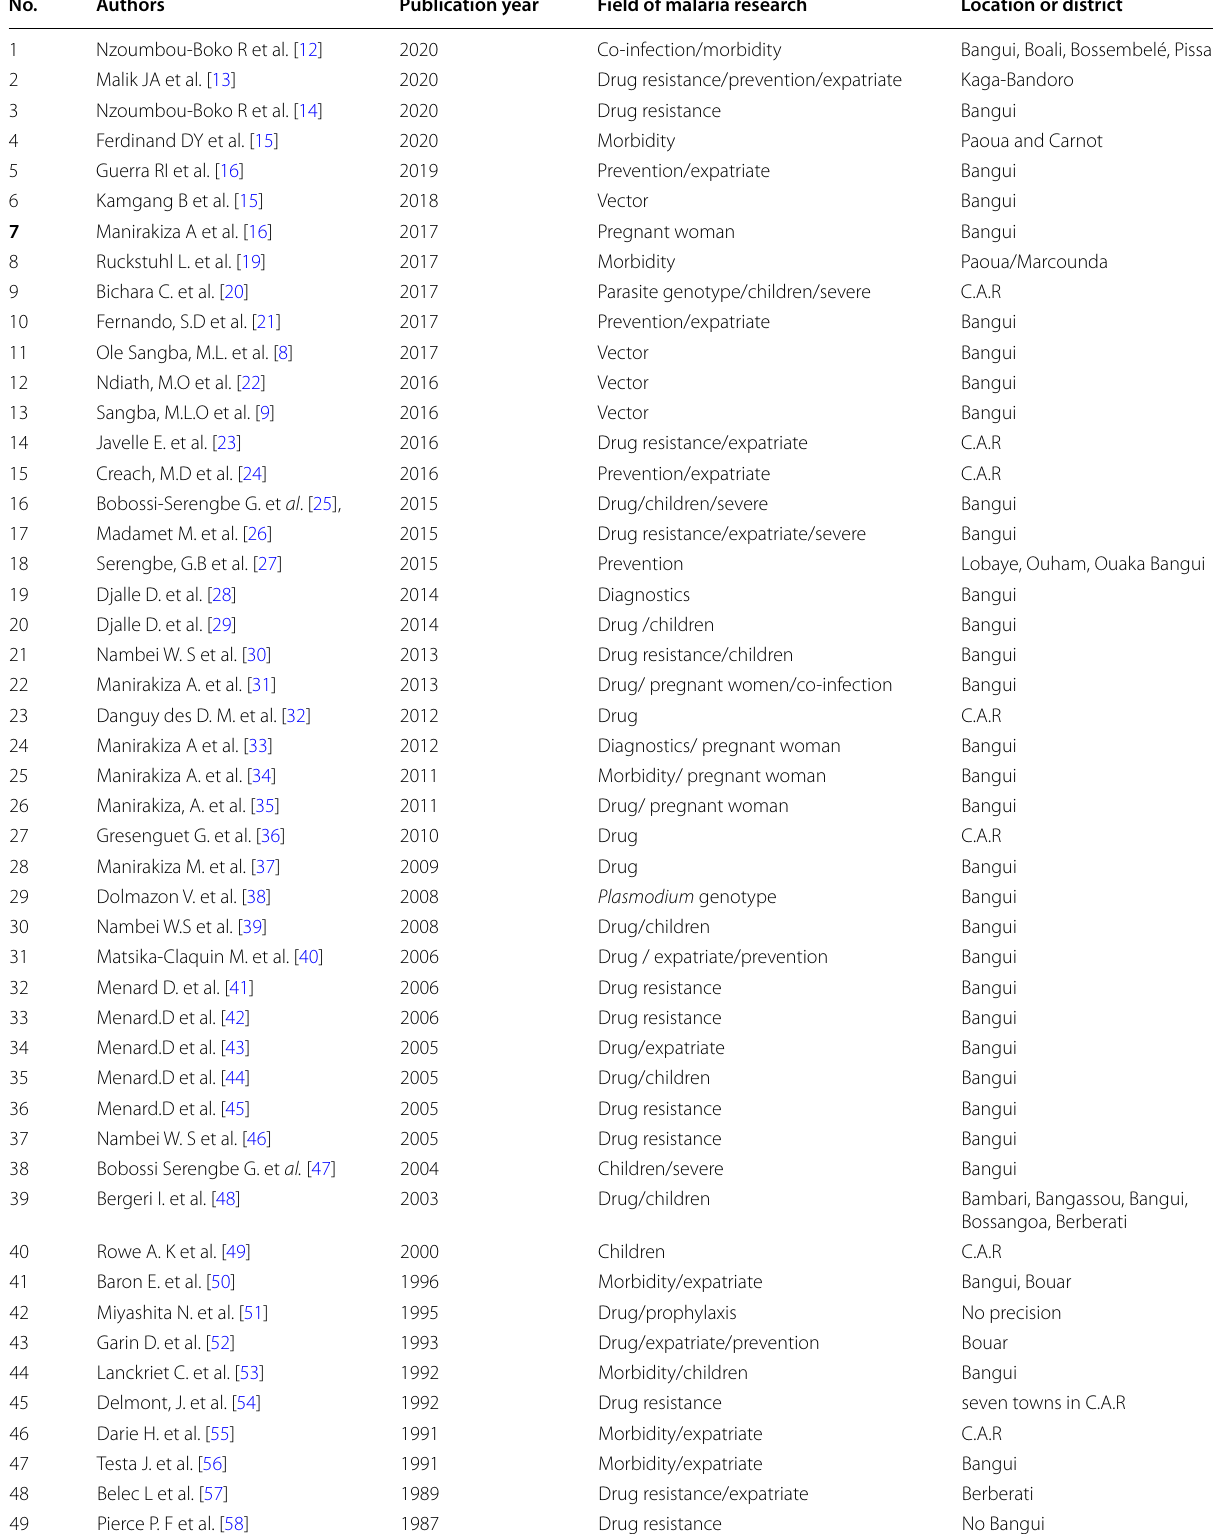
Table 2 Summary of the studies included in the review